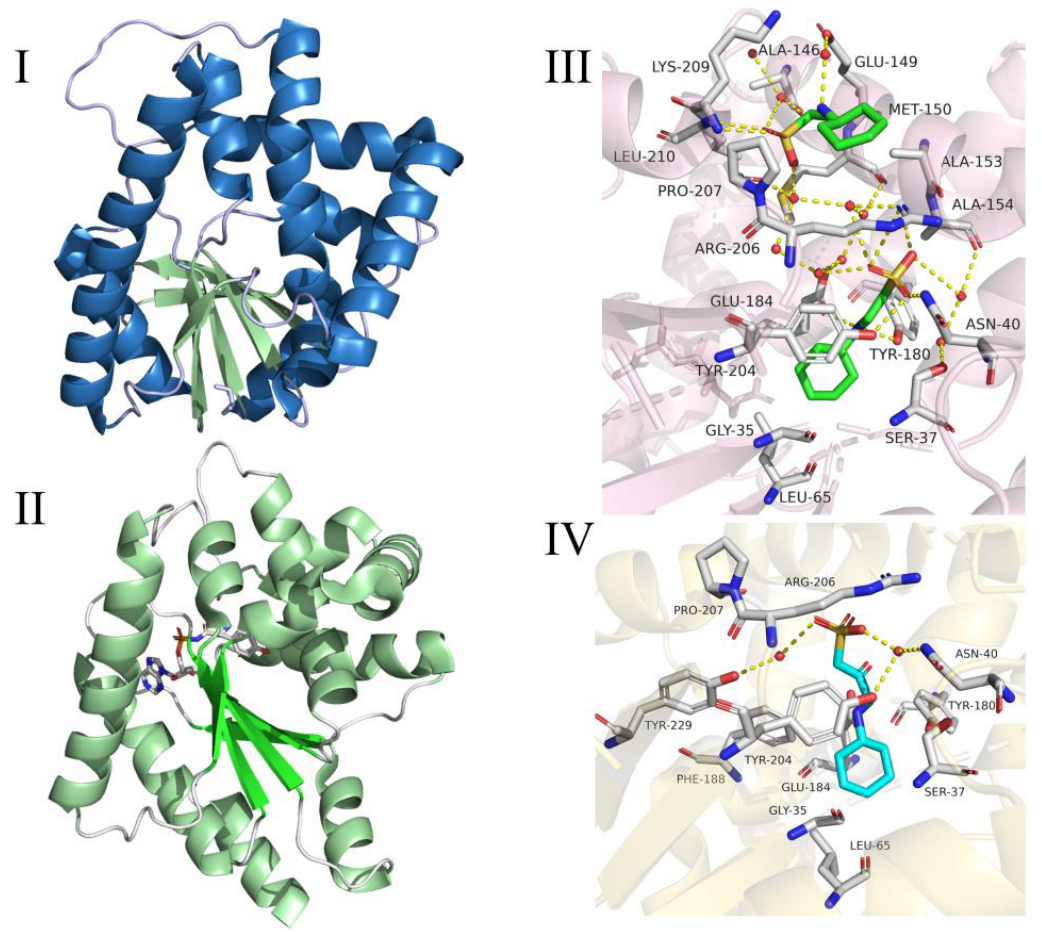
Figure 5. ( I ) The overall structure of YvmC-Blic. Each type of secondary structure has a different color: the ring is light blue, the helix is sky blue, and the strand is pale green [14]; ( II ) the overall structure of the yeast TyrRS catalytic domain (PDB ID 2DLC), which is similar to the overall structure (A) of YvmC-Blic. Catalytic site-bound tyrosyl-adenylate analogs were drawn using a spherical model [14]; ( III ) YvmC-Blic with two 2-cyclohexylaminoethanesulfonic acid (CHES) molecules in pockets. Water molecules appear as red spheres. Hydrogen bonds are indicated by yellow dashed lines [14]; ( IV ) YvmC-Blic with two CAPSO molecules bound to the pocket [14].